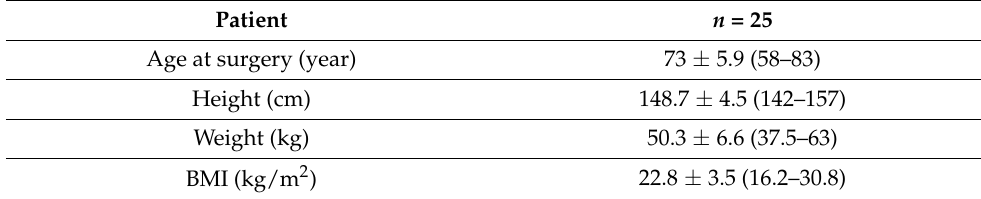
Table 1. Patient